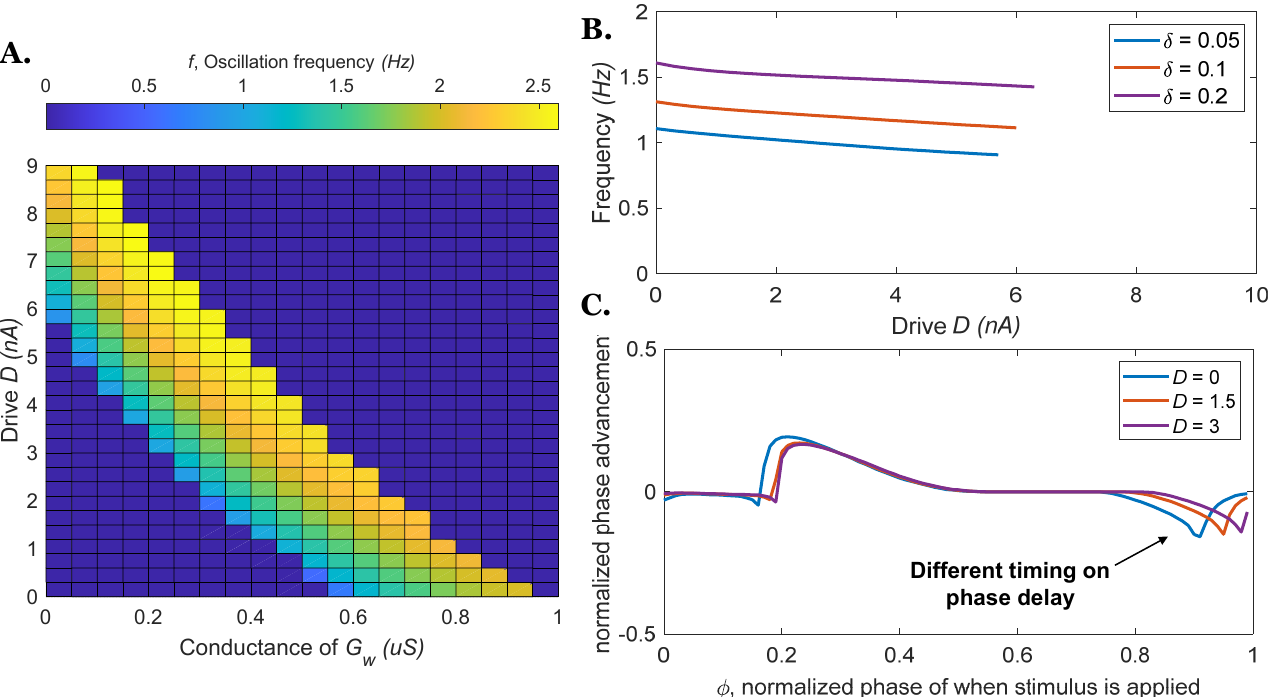
Figure 4. The frequency of the rhythm generator and phase response curves vary as a function of neural parameters (descending drive D or coupling conductance G w ). ( A ) Various combinations of D and G w can control the oscillation frequency (presented as a color map) of the rhythm generator. ( B ) Different combinations of parameters might result in the same δ values, but the frequencies will be different. ( C ) The phase response curves for δ = 0.1 with different parameter combinations. The phase response curves are relatively similar, however, differences clearly exist.